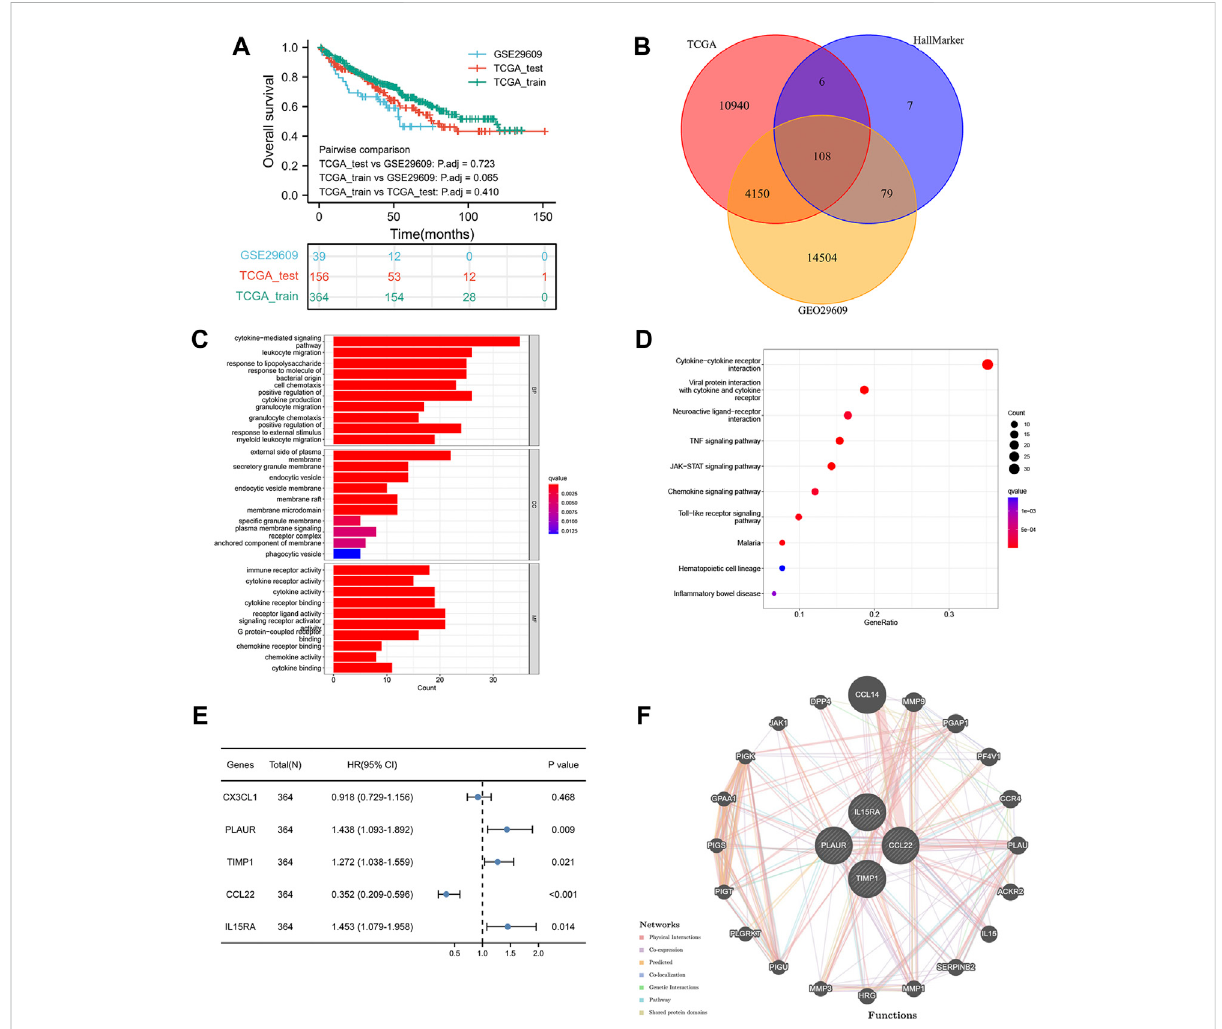
FIGURE 2 Construction of in fl ammation-related signature: the overall survival of included patients (A) , the Venn diagram of differentially coexpressed genes (B) , the GO result (C) , the KEGG result (D) , the results of fi ve genes in multivariate Cox regression model (E) , the result of protein – protein interaction network (F)